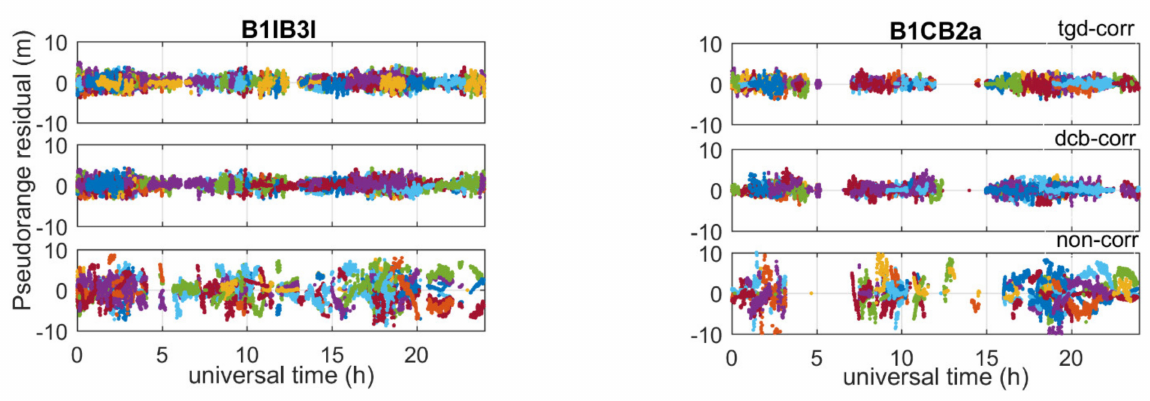
Figure 20. Pseudorange residual scatters of B1I/B3I and B1C/B2a SPP with different schemes at BRCH